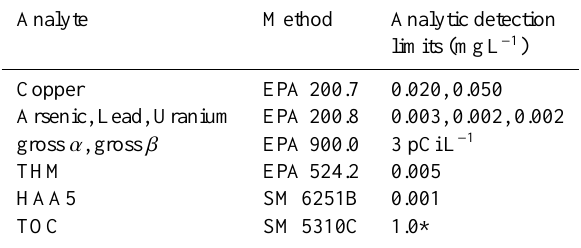
* The analytic detection limit is based on linear regression analysis of the calibra- tion curve, conducted with three replicates each of 4 standards, ranging from